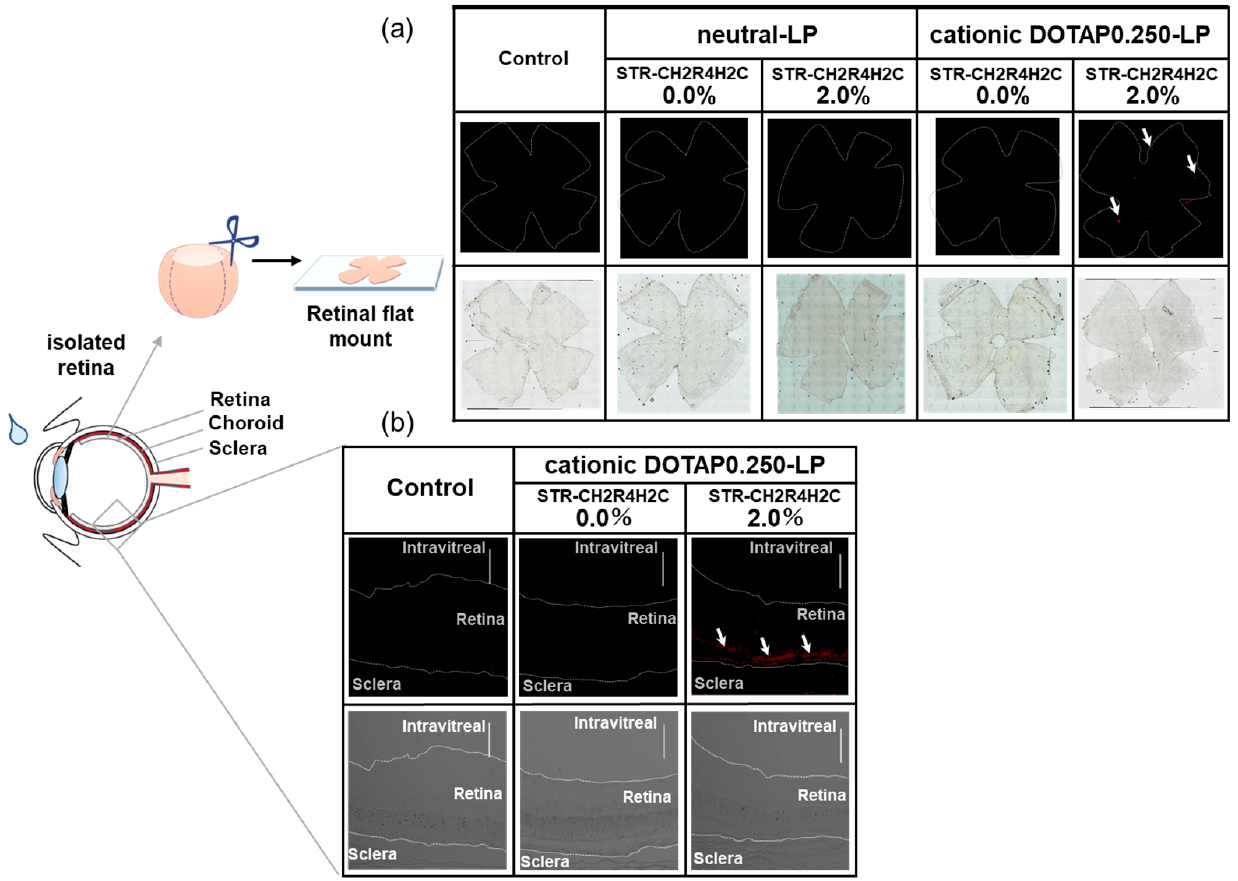
Figure 5. Migration of neutral STR-CH2R4H2C-LP and cationic STR-CH2R4H2C-LP into retinas 2 h after instillation into rat eyes ( a ) and distributions of cationic DOTAP0.250-LP in the posterior segment of the eye ( b ). (a) Effects of STR-CH2R4H2C modification and surface charges on migration into rat CH2R4H2C-LP, cationic DOTAP0.250-LP, and cationic 2.0 mol% STR-CH2R4H2C- DOTAP0.250-LP were instilled into the right eyes of rats (Total lipid 0.60 µmol/20 µL/eye). After 2 h, the eyeballs were removed, and retinal flat mounts were prepared. The fluores- cence of ATTO-labeled LPs was observed using a fluorescence microscope. Exposure time was set using the untreated left eye of each rat as a control. Magnification: 100×. (b) ATTO647N-DOPE-labeled DOTAP0.250-LP and 2.0 mol% STR-CH2R4H2C- DOTAP0.250-LP (Lipid, 0.18 µmol/30 µL) were instilled in 30 µL to rat eyes. The eyeballs were removed, and the eye tissue sections were prepared. The liposome distribution of retinal tissue was observed using CLSM. Red color indicates ATTO647N-DOPE. Scale bar: 100 µm, magnification: 200×. 4. Discussion Positively-charged peptides, such as HIV-Tat-derived peptide rich in arginine and R- 8 (Arg-Arg-Arg-Arg-Arg-Arg-Arg-Arg) peptide, possess superior cell permeability and gene delivery ability [23–25]. We previously synthesized a cytoplasm-responsive